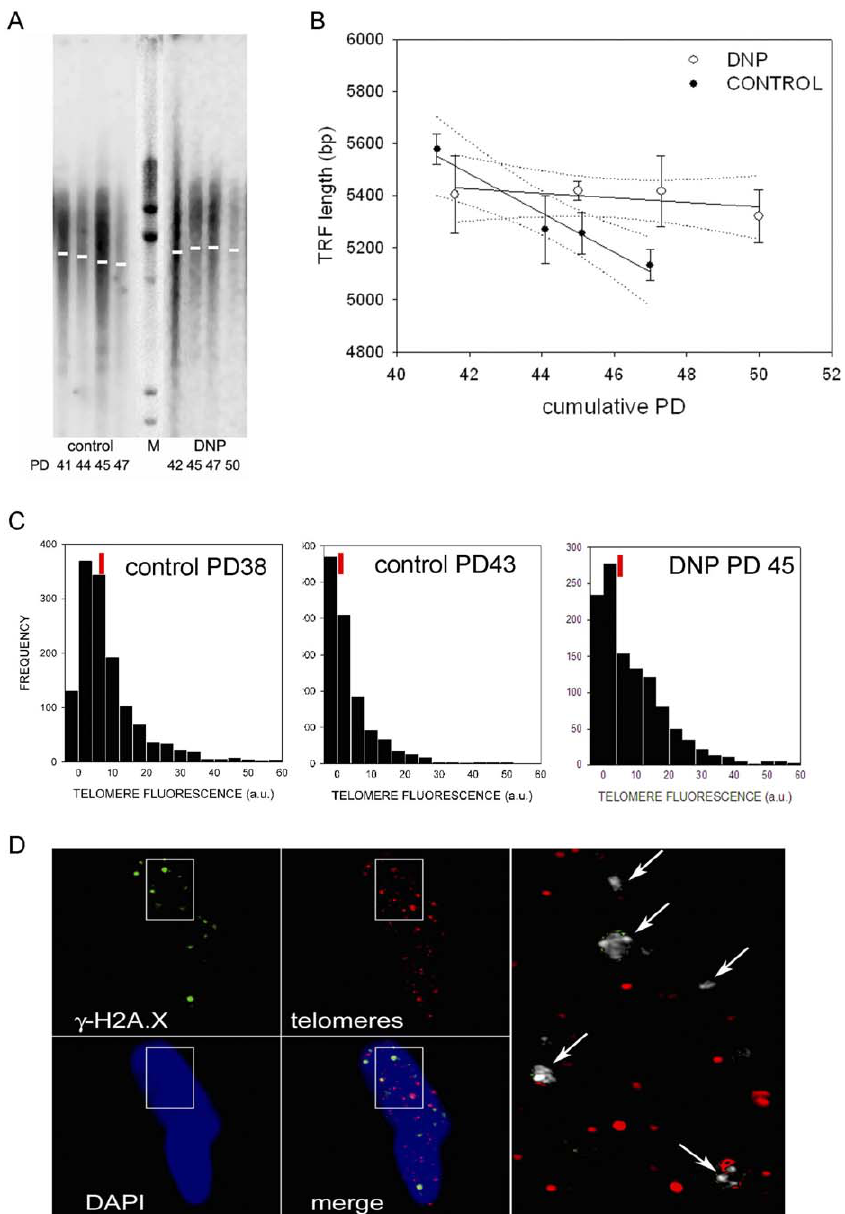
Figure 4. Delayed Senescence in DNP-Treated Fibroblasts Is Telomere Dependent (A) Telomere in-gel hybridisation of untreated (control) and DNP-treated MRC5. The size-weighted average of each peak is indicated by a white line. A k HindIII DNA digest is used as size marker (M). (B) Average telomere (TRF) length in controls and DNP-treated MRC5 fibroblasts. Data are mean 6 s.e.m. from quadruplicate gels. Solid line: linear regression, dotted lines: 95% confidence intervals. Differences between slopes are significant (2-tailed t test, p ¼ 0.002). (C) Telomere Q-FISH histograms of untreated (control) and DNP-treated MRC5 at the indicated PD. Medians are indicated by red bars and are at 6.0 arbitrary units (a.u.) (control PD 38), 1.3 a.u. (control PD 43), and 5.7 a.u. (DNP PD 45). Histograms of control PD 43 and DNP PD 45 are significantly different from each other according to a Mann-Whitney test ( p -value , 2.2 3 10 (cid:2) 16 ). (D) ImmunoFISH of senescent DNP-treated cells at PD 50. c -H2A.X–containing foci are shown in green and telomeres in red. The boxed area is shown as deconvoluted image at higher magnification at the right. Pixels that show significant co-localisation between foci and telomeres according to a Pearson correlation analysis are shown in white (indicated by